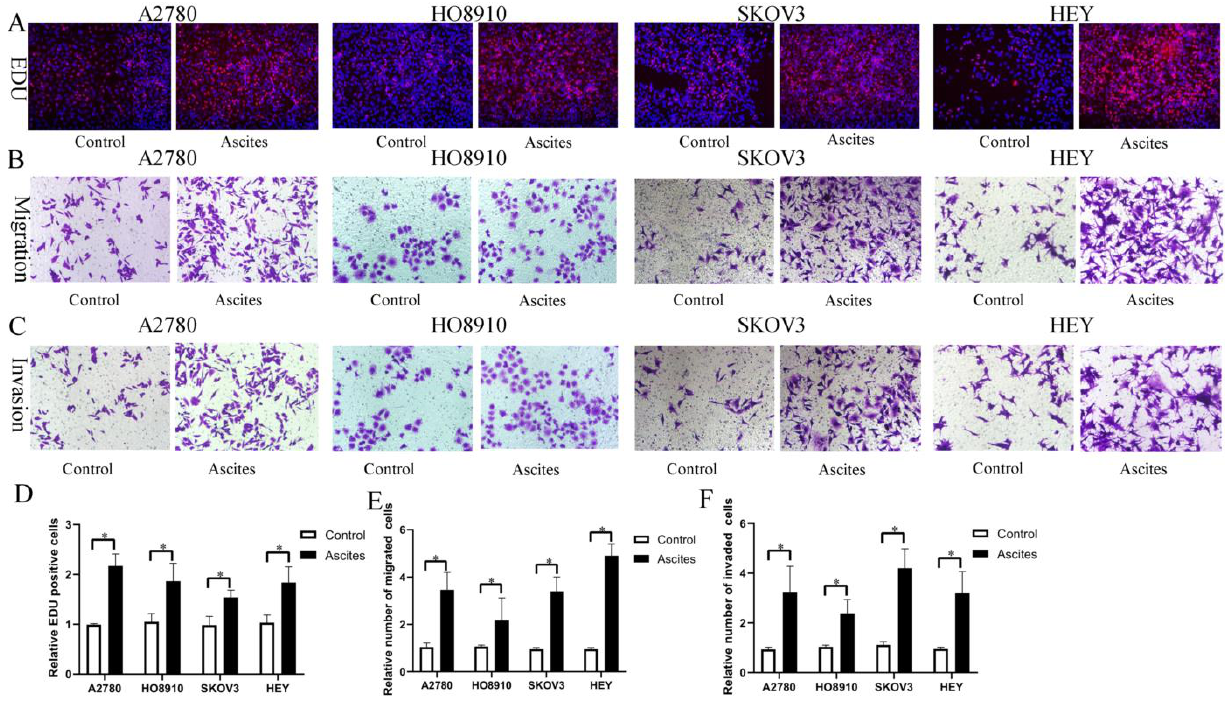
Figure 9. Ovarian cancer ascites increase human EOC cell proliferation, migration, and invasion (A2780, HO8910, SKOV3, and HEY) in vitro. ( A ). The effect of ascites on human EOC cell line proliferation was measured by EdU assay. ( B ). The effect of ascites on human EOC cell migration was measured by Transwell assay. ( C ). The effect of ascites on human EOC cell invasion was measured by Transwell assay. ( D ). Quantification of proliferation rates showed that the proliferative capacity of human EOC cell lines was significantly improved after ascites treatment. ( E ). Quantification of the migrated cells showed that human EOC cell migratory capacity was significantly improved after ascites treatment. ( F ). Quantification of the invasion rates of human EOC cell lines showed that the invasive capacity of human EOC cell lines was significantly improved after ascites treatment. * p < 0.05, n = 3.